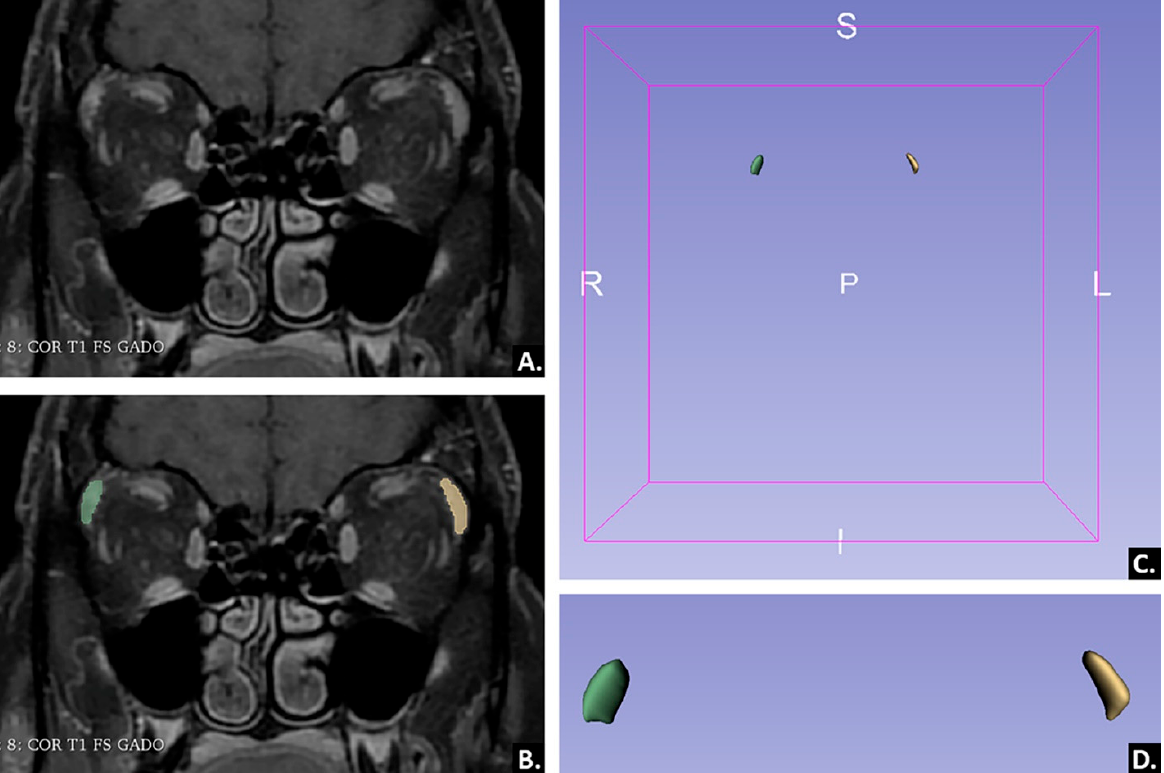
Figure 3. Example of lacrimal gland segmentation in a patient diagnosed with primary Sjögren’s Syndrome. Coronal contrast-enhanced T1-weighed image with fat saturation, before segmentation ( A ) and after segmentation ( B ); 3D reconstruction of the lacrimal glands ( C ); magnified 3D reconstruction of the lacrimal glands ( D ).